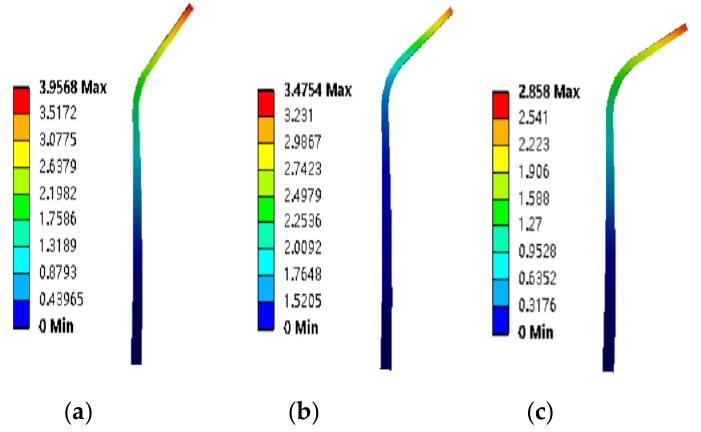
Figure 5. Stress clouds for different bending angles of rotary cutter. ( a ) 130° ( b ) 120° ( c ) 110°.